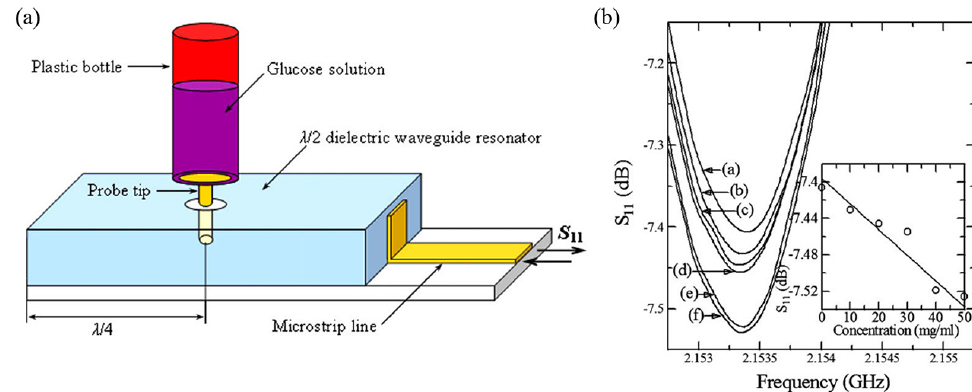
Figure 7. Glucose concentration detection using a TM 011 mode metal cavity and a near − field microprobe. ( a ) Configuration of the sensor. ( b ) Variation in the reflection coefficient as a function of the glucose concentration. ((a) DI water, (b) 10 mg/mL, (c) 20 mg/mL, (d) 30 mg/mL, (e) 40 mg/mL and (f) 50 mg/mL) (Reprinted with permission from [68]; published by Elsevier,